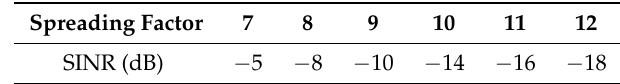
Figure 5. The packet error rate (PER) versus signal-to-interference-plus-noise ratio (SINR) with different Spreading Factor (SF) in LoRa modulation. Table 4. The lowest SINR values limit in LoRa chirp spread spectrum (CSS) modulation with six spreading factors and 125KHz